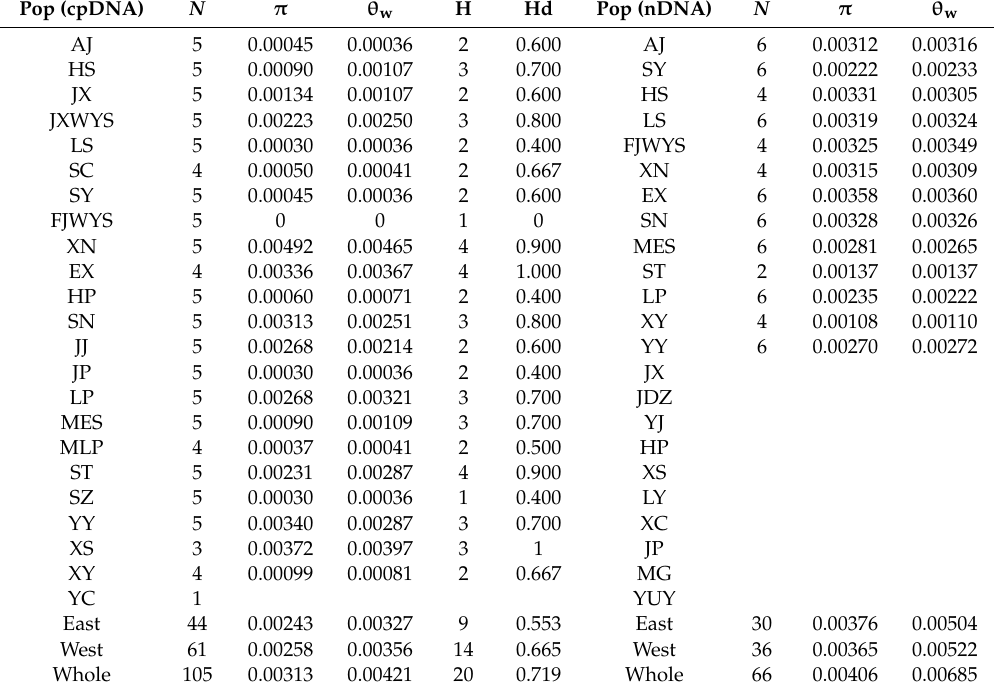
Table 5. Genetic diversity revealed by chloroplast DNA (cpDNA) and nuclear DNA (nDNA) in natural populations of L. chinense